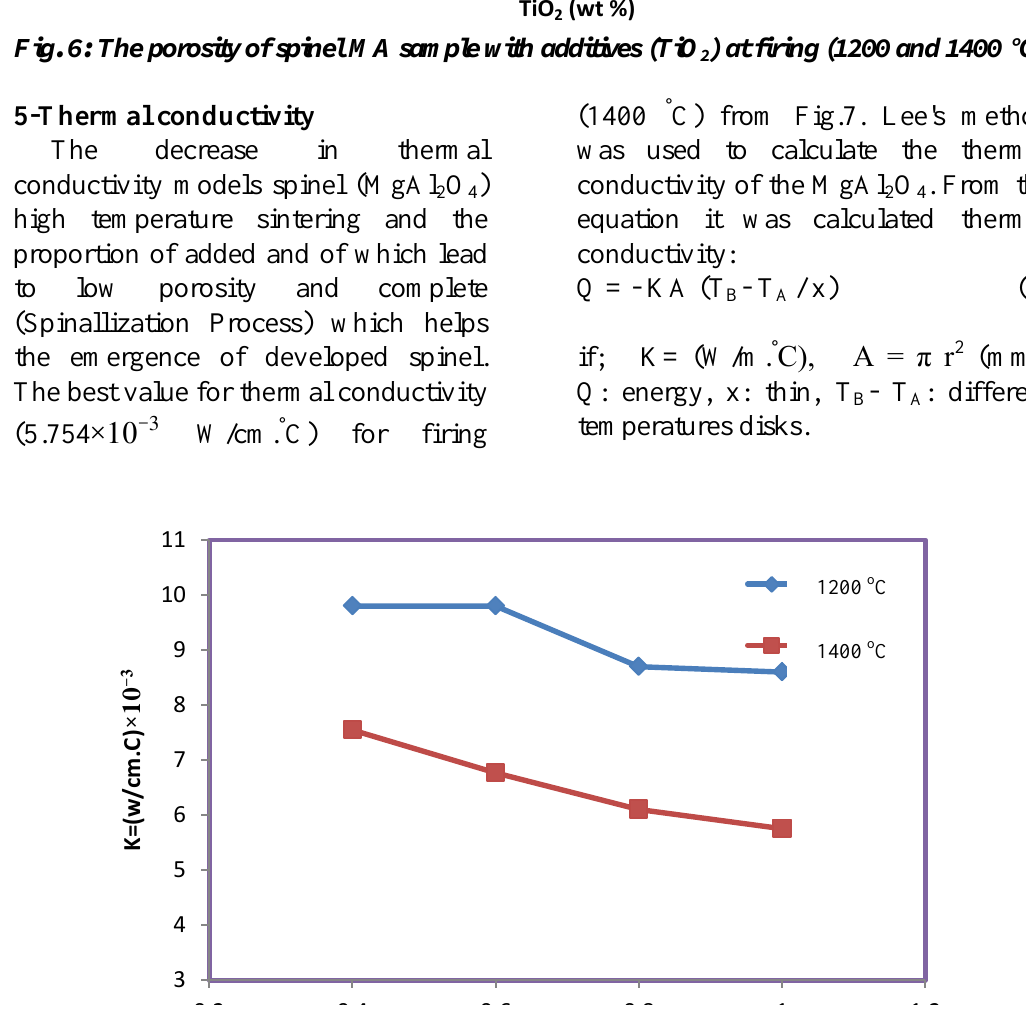
) at firing (1200 and 2